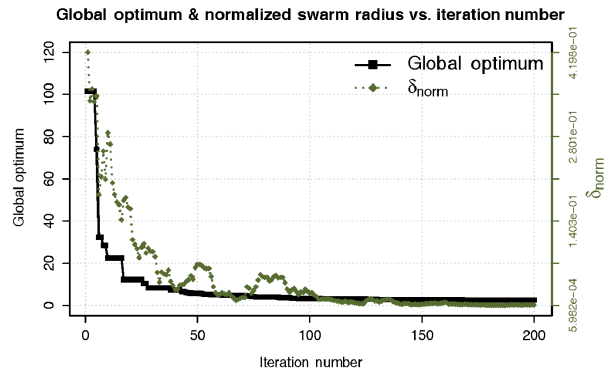
Figure 3. Evolution of the normalized swarm radius ( δ norm) and the global optimum (SSR) over 200 iterations.